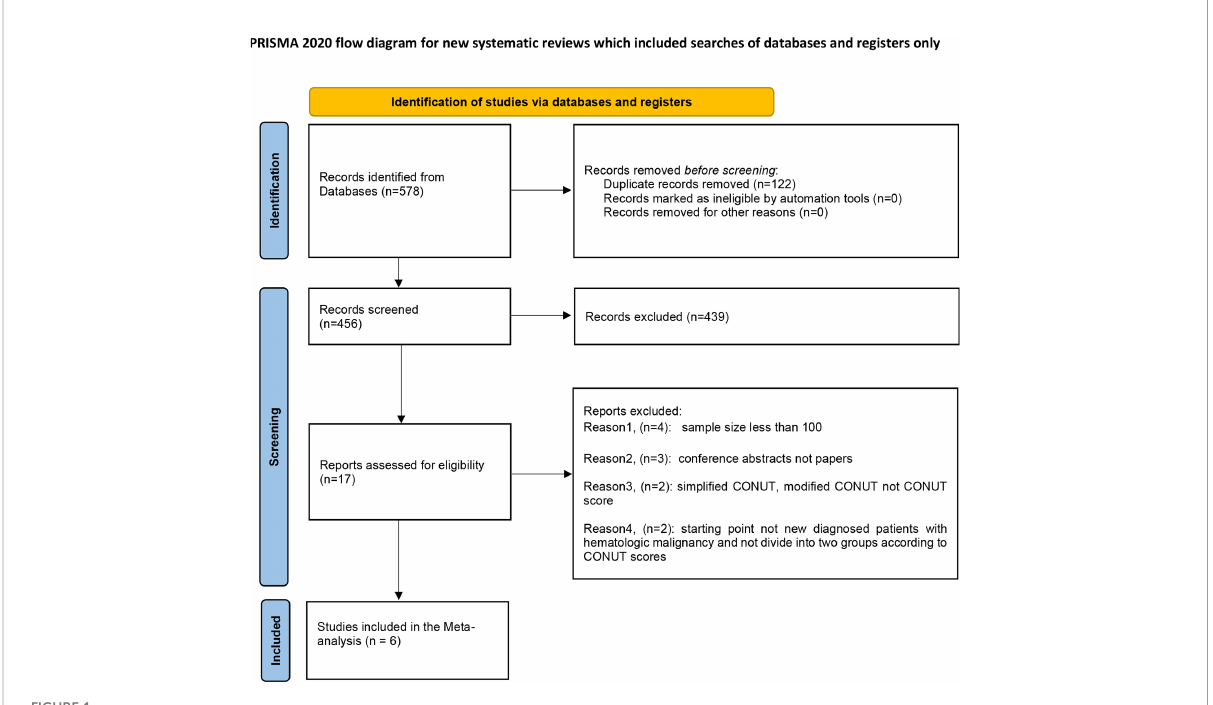
FIGURE 1 The fl ow diagram of the search and selection